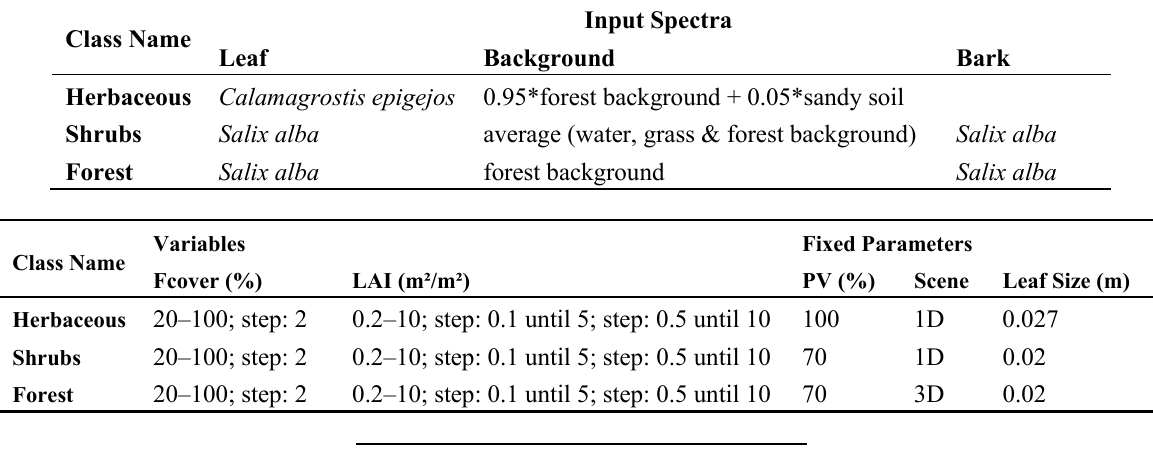
Table 3. FLIGHT model parameters and variables, and input spectra. Fcover: fractional vegetation cover, LAI: leaf area index, PV: photosynthetic vegetation, 1D: 1dimensional, 3D: three dimensional; DBH: diameter breast height. Details about the FLIGHT parameters can be found in